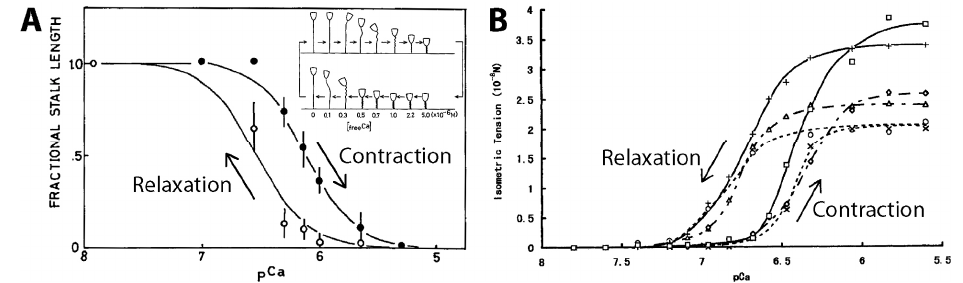
Figure 8. Calcium-dependency of Vorticella ’s stalk contraction. ( A ) The contraction-relaxation cycle of the extracted stalks of V. convallaria responding to changes in [Ca 2+ ] free (reproduced from [20]). Inset: Shape changes of V. convallaria depending on [Ca 2+ ] free (reproduced from [58]); ( B ) isometric tension developed by the extracted stalk of V. convallaria responding to changes in [Ca 2+ ] free (reproduced (cid:104) (cid:105) from [23]). Here, pCa = − log Ca 2 + . 10 free